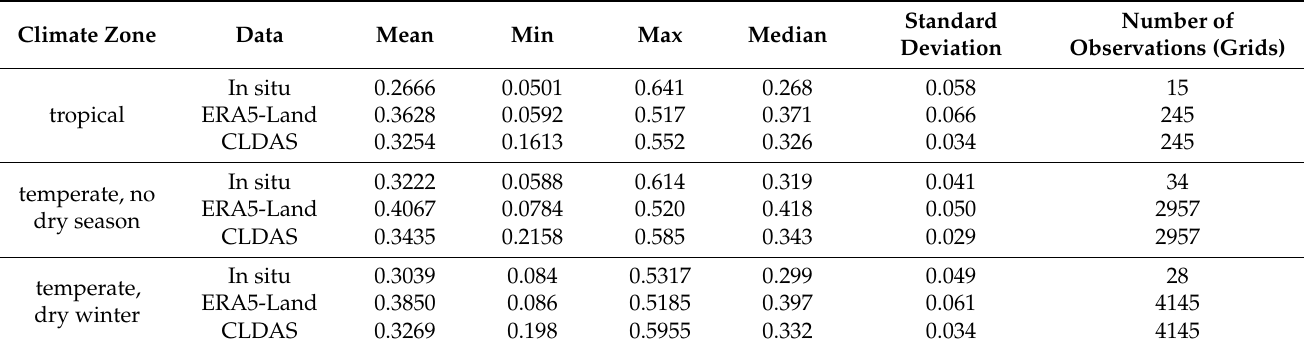
Table 1. Statistical characteristics of the in situ, CLDAS, and ERA5-Land SM (m 3 /m 3 ) of different climate